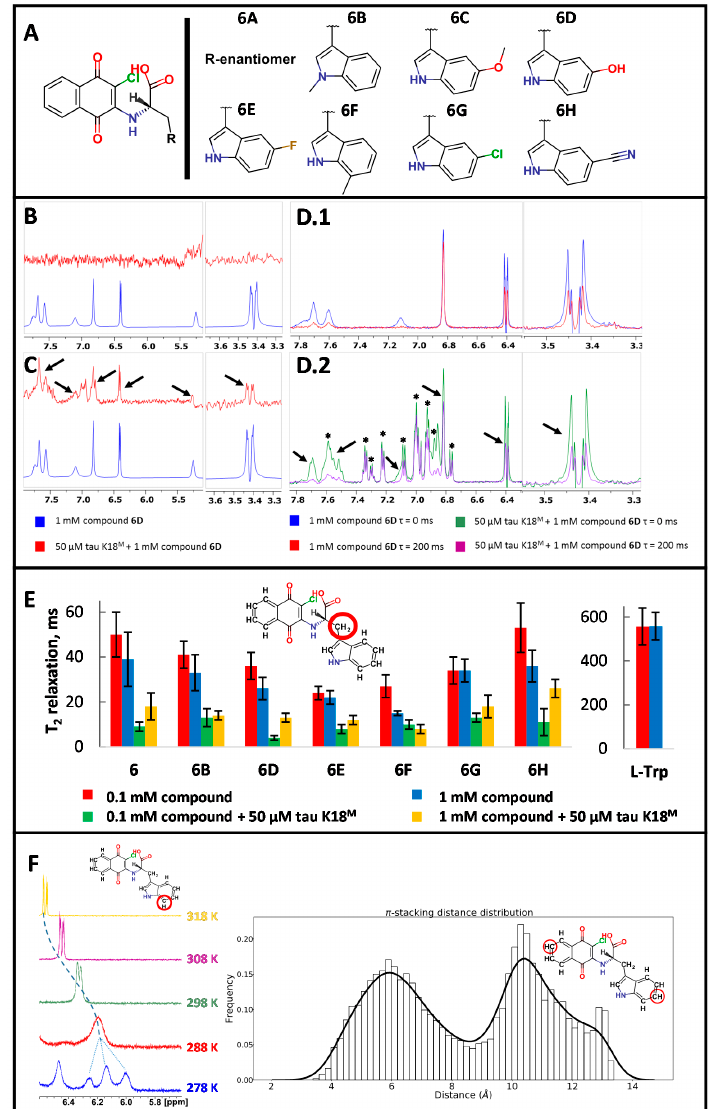
Figure 3. 1D ligand-observed NMR studies with Cl-NQTrp and its near neighbors (NNs). ( A ) Synthesized NNs of Cl-NQTrp. ( B ) Saturation transfer di ff erence (STD) data (red) indicates no ligand-specific signals when compared to 1 H reference spectrum (blue) for compound 6D. ( C ) Water–ligand observed via gradient spectroscopy (water-LOGSY) data (red) indicates ligand-specific peaks (black arrows) when compared to a 1 H reference spectrum (blue) for compound 6D. ( D ) 1 H Carr–Purcell–Meiboom–Gill (CPMG)-filtered data for compound 6D in the absence ( D.1 ) and presence ( D.2 ) of tau K18 M (protein-derived peaks marked as ∗ ) indicates no IDP–ligand interactions using standard (200ms) relaxation delays as ligand-specific peaks (black arrows) decreased in intensity at a similar level after CPMG filter. ( E ) Comparison of T 2 relaxation times for tryptophan methylene group (red circled) at di ff erent concentrations of compound 6 and its NNs in the presence or absence of tau K18 M . L-Trp T 2 relaxation times were measured without any protein present. ( F ) 1 H NMR spectral changes for red-circled proton of Cl-NQTrp indicating decreasing intensity, coalescence, splitting, and sharpening of the signal with decreasing temperature indicating intermediate chemical exchange events (Left). Over a 1 µ s simulation in explicit water, Cl-NQTrp adopts either folded or unfolded conformation close to 50% of the time (Right). Atom pair distance: 4 to 8 Å between the red-circled carbon atoms in folded and 9–13 Å in unfolded